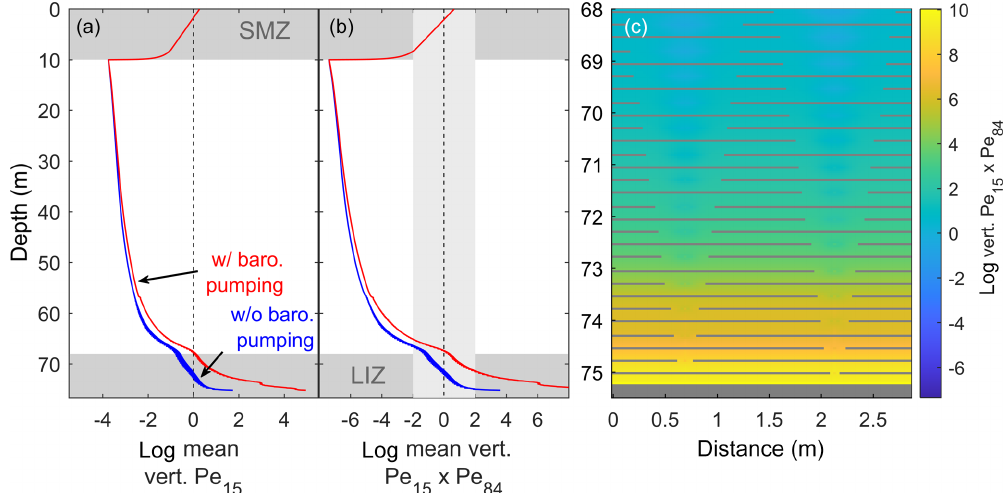
Figure 13. The balance of fractionating and non-fractionating mixing at WAIS Divide. Panel (a) illustrates the horizontally averaged modified Péclet number of δ 15 N ( Pe 15 , see text). Blue and red lines show results from the 2-D models with and without barometric pumping. The strength of dispersive mixing in the calculations is given by the mean barometric pumping flow velocities at the site. Panel (b) displays the product of the modified Péclet numbers for δ 15 N and 84 Kr / 28 N 2 ( Pe 84 ). The region where (cid:15) (cid:48) changes with depth should be greatest (i.e., where the product of the modified Péclet numbers is near 1) is highlighted by a gray bar. Panel (c) provides a magnified 2-D map of this Péclet number product in the